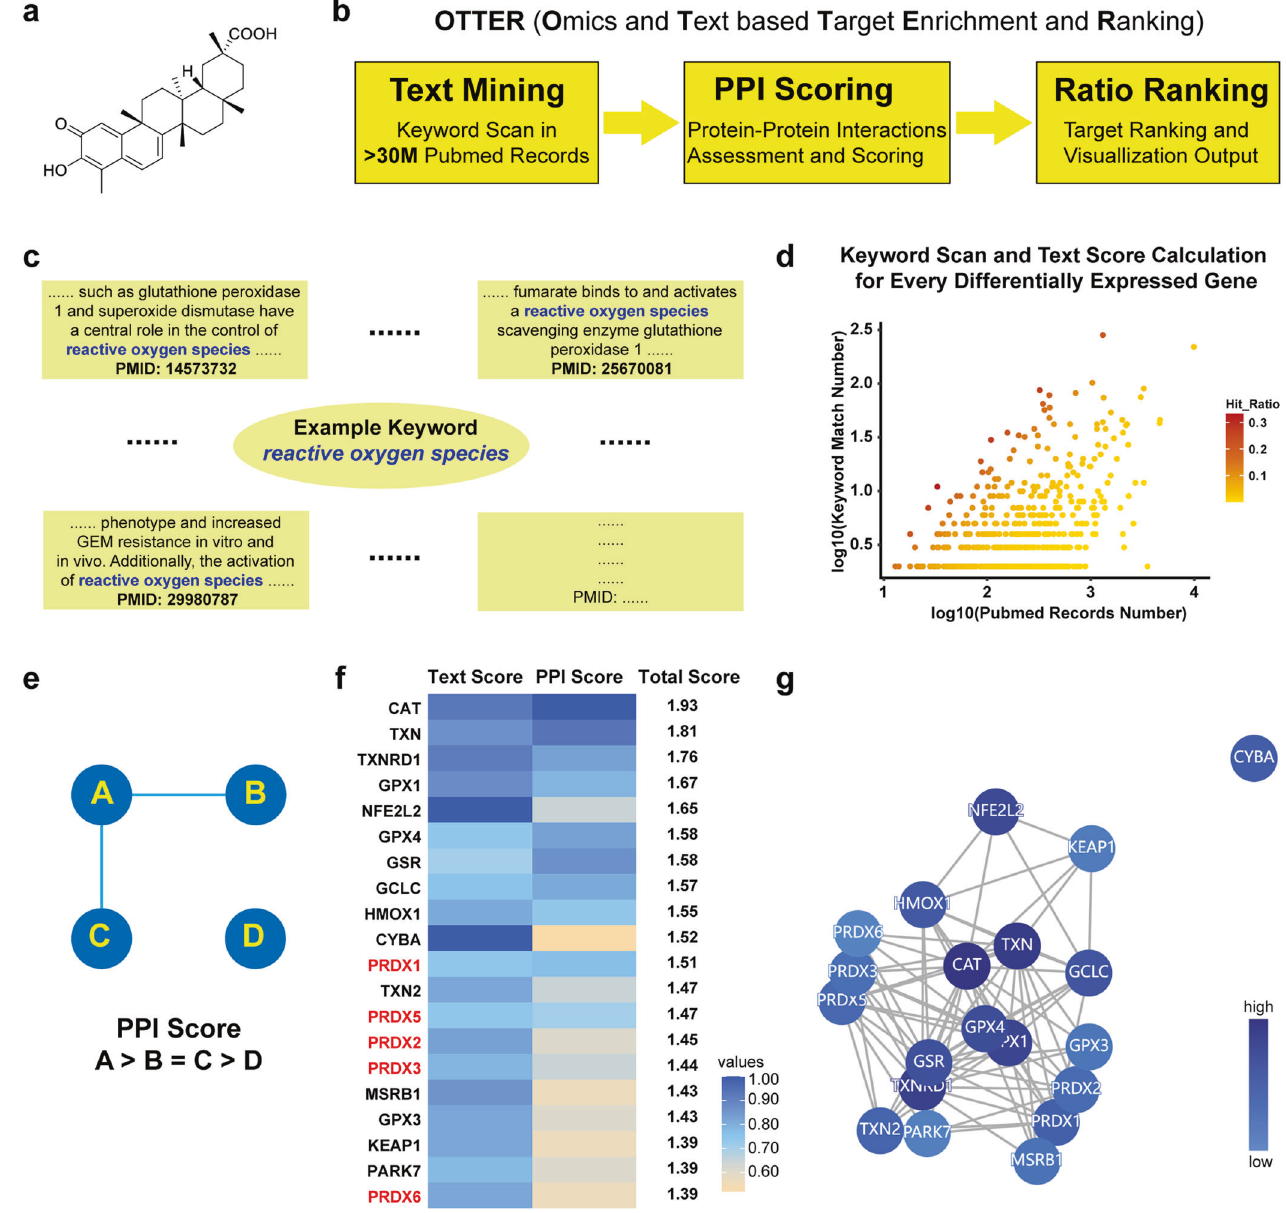
Fig. 1 A new computational tool named OTTER for target identi fi cation. a The chemical structure of Celastrol. b The work fl ow of OTTER consists of three steps, including text mining in PubMed abstracts, scoring with protein-protein interactions, and ranking with visualization. c Illustrative diagram for the text mining process of OTTER. Several abstracts containing the keyword “ reactive oxygen species ” were chosen as an example. For each gene in the list provided by users, the user-de fi ned keyword is scanned in all the PubMed abstracts of this gene. d Text mining and scores calculation are performed for every differentially expressed gene in the list provided by users. For each gene, a hit ratio is calculated using the Keyword Match Number divided by the PubMed Record Number. Then a hit ratio is normalized as a Text Score for every gene in the list. e The rule used by OTTER for protein-protein interaction assessment. After the calculation of Text Scores, these genes are scored with the protein-protein interaction records from the STRING database. The genes involved in more protein-protein interactions with other genes in the list are given higher PPI Scores. f The top-ranking 20 differentially expressed genes according to total scores calculated by OTTER, using the RNA sequencing data from cells treated with Celastrol, and the keyword “ reactive oxygen species ” . g The interactive plot generated by OTTER, using top-ranking 20 differentially expressed genes according to fi nal scores. Colored nodes represent top-ranking genes after enrichment, while lines represent protein-protein interactions between these genes. Nodes with higher scores are colored in darker blue protein of Celastrol, which is able to manipulate the redox damage by further ROS elevation induced by exogenous agents, homeostasis in various cancer cells, is promising for the anti- which can induce apoptosis and cell cycle arrest in cancer cells tumor drug discovery and development. However, the relationship partly mediated by the p53 signaling pathway. 14,16 Then, it is between ROS, Celastrol and p53 signaling pathway in colorectal feasible to selectively kill cancer cells via ROS manipulating, without cancer remains undiscovered. causing signi fi cant toxicity to normal cells. 14 The underlying target Signal Transduction and Targeted Therapy (2023)